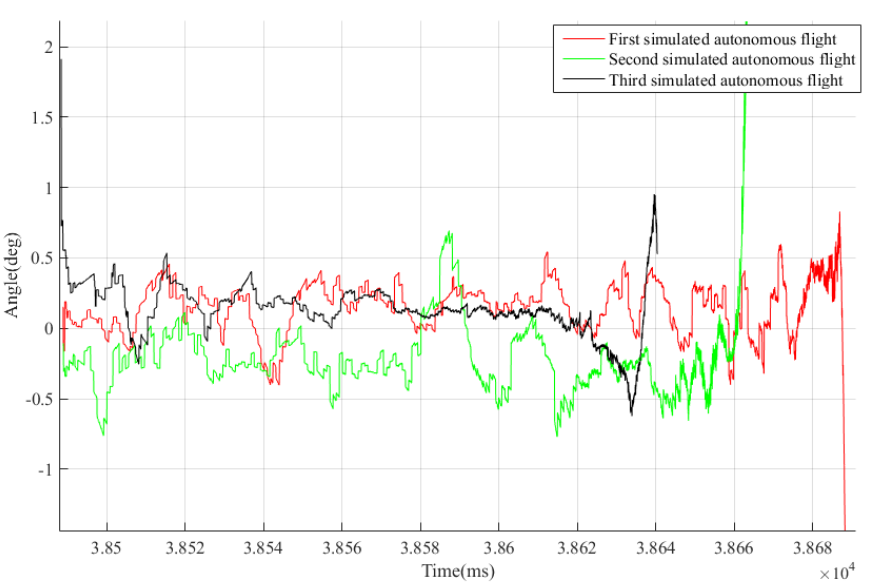
Figure 18. Heading angle error of the target measured by the airborne radar.